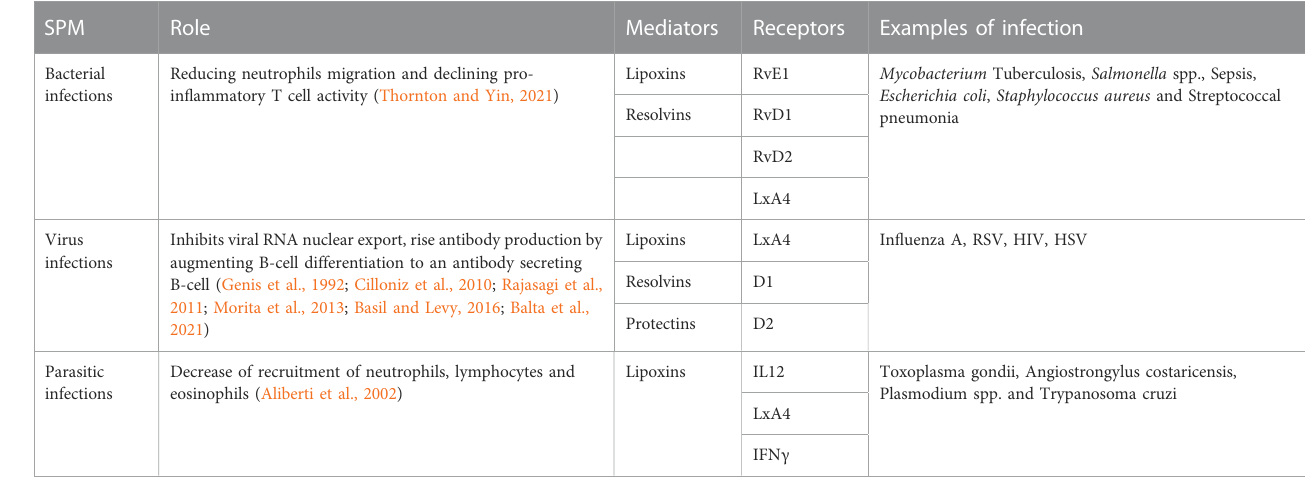
TABLE 1 SPMs in fl uence host defense and infectious in fl